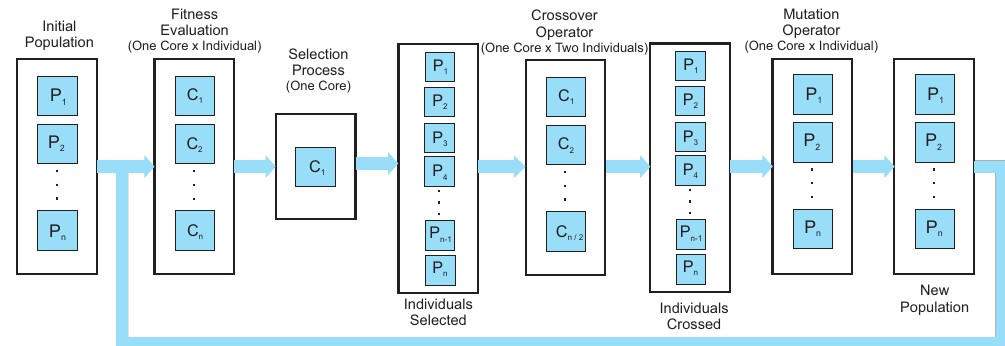
Figure 3. Parallelization